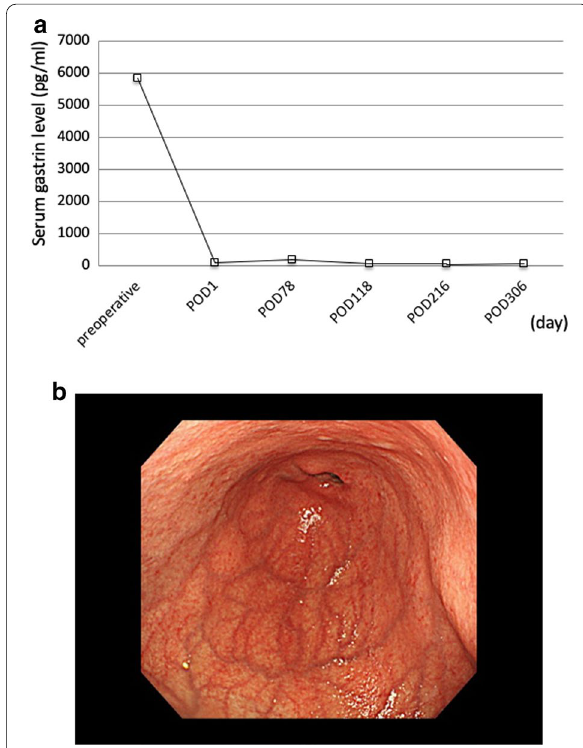
Fig. 4 Postoperative fluctuations in gastrin levels and endoscopic findings. a Serum gastrin level decreased immediately within the normal range after the SILA and continued without any increase thereafter. b EGD performed at one year after surgery showed complete disappearance of all lesions of the remnant